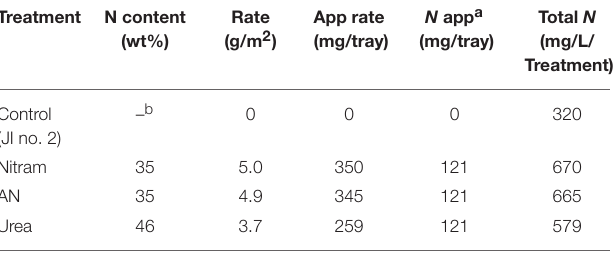
TABLE 1 | Nitrogen content of each fertilizer treatment for equivalent nitrogen application rate. N app a Total N Treatment N content Rate App rate (wt%) (g/m 2 ) (mg/tray) (mg/L/